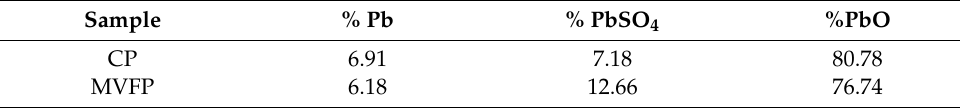
Table 4. Chemical analysis of the negative pastes after